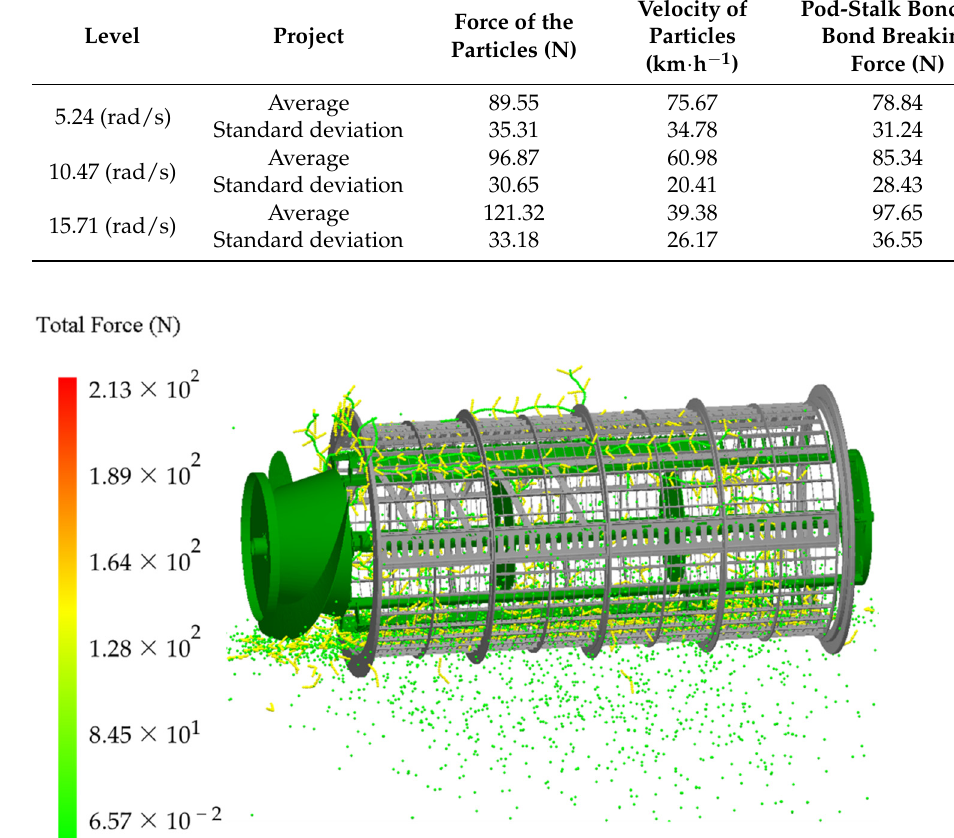
Figure 9. Force cloud diagram of different type of particles.